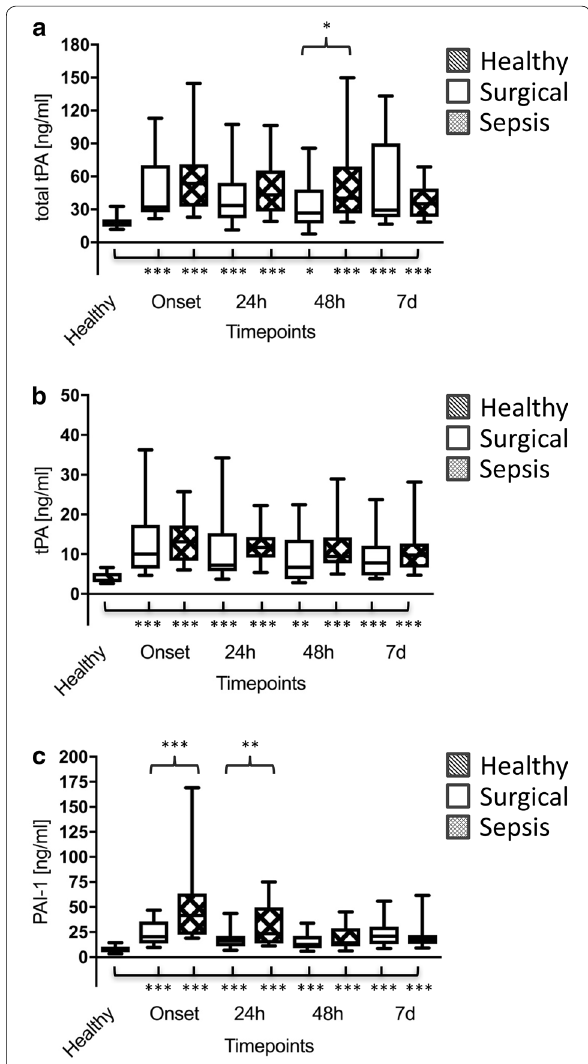
Fig. 2 Total thrombin plasminogen activator (total tPA) ( a ), free thrombin plasminogen activator (tPA) ( b ) and plasminogen activator